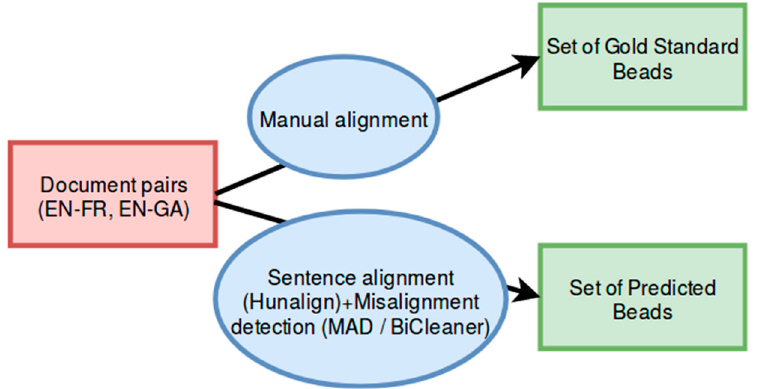
Figure 8. Intrinsic evaluation on Gold Standard for alignment.